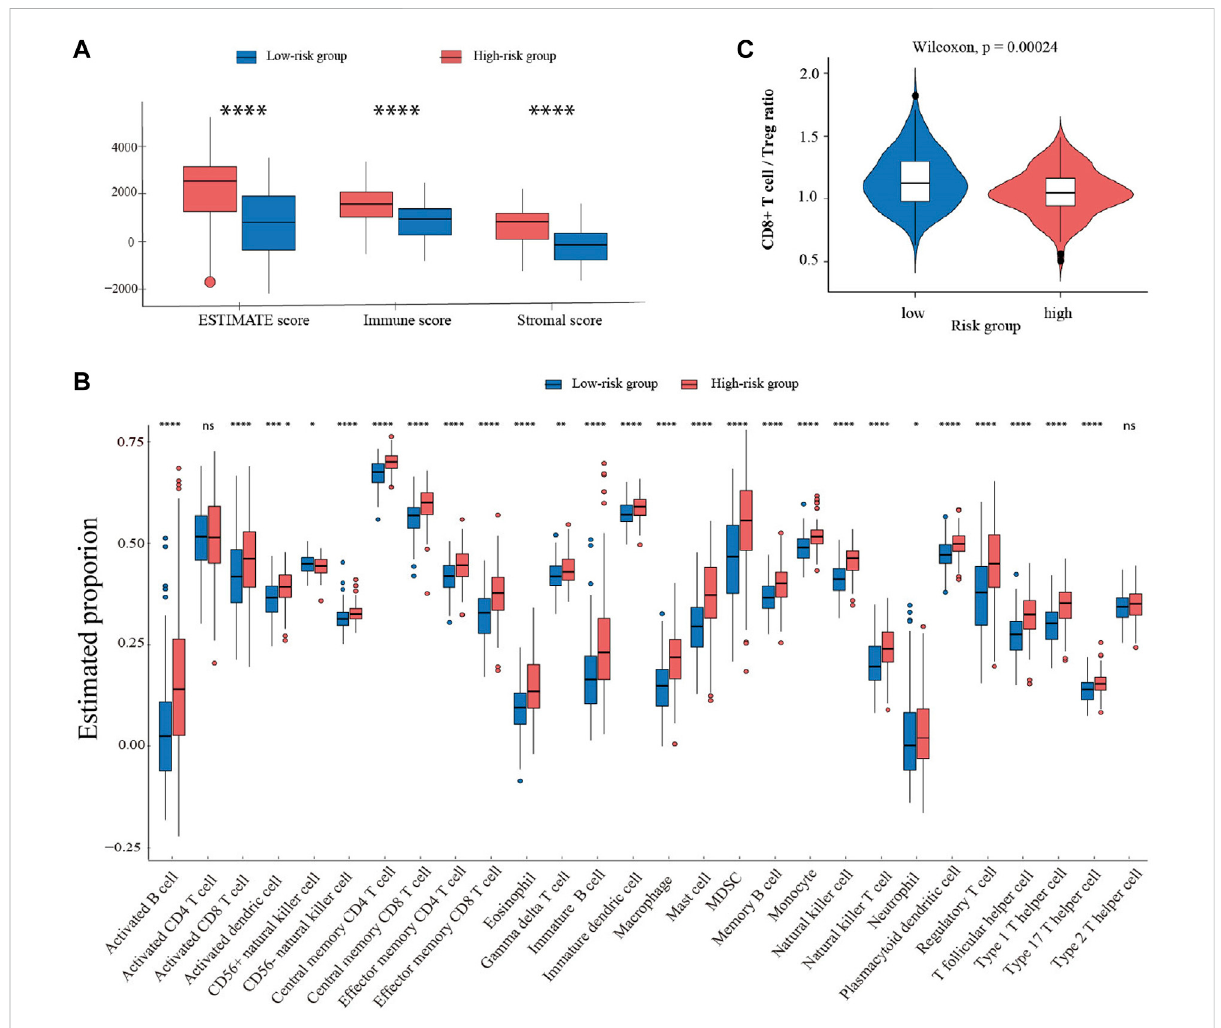
Comparison of immune pro fi les in two groups with different FCGRT expression (A) Boxplot of the ESTIMATE score. (B) The abundance of each immune cell type in the two groups. (C) The ratio of CD8+T/Treg cells in the FCGRT high